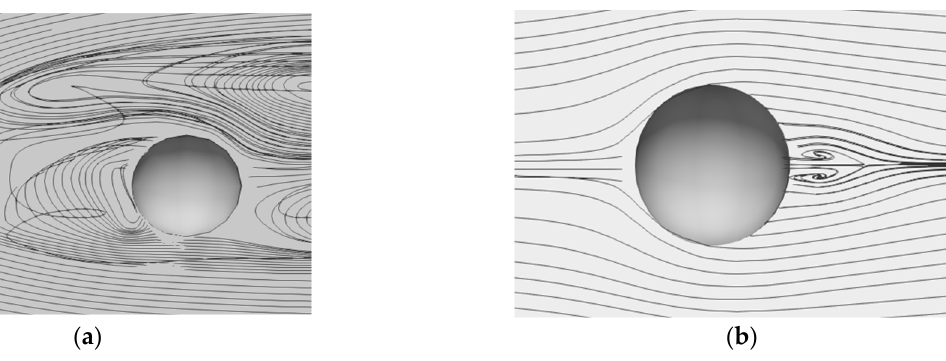
Figure 9. ( a ) Streamline of disturbance area; ( b ) streamline of non-disturbance area.